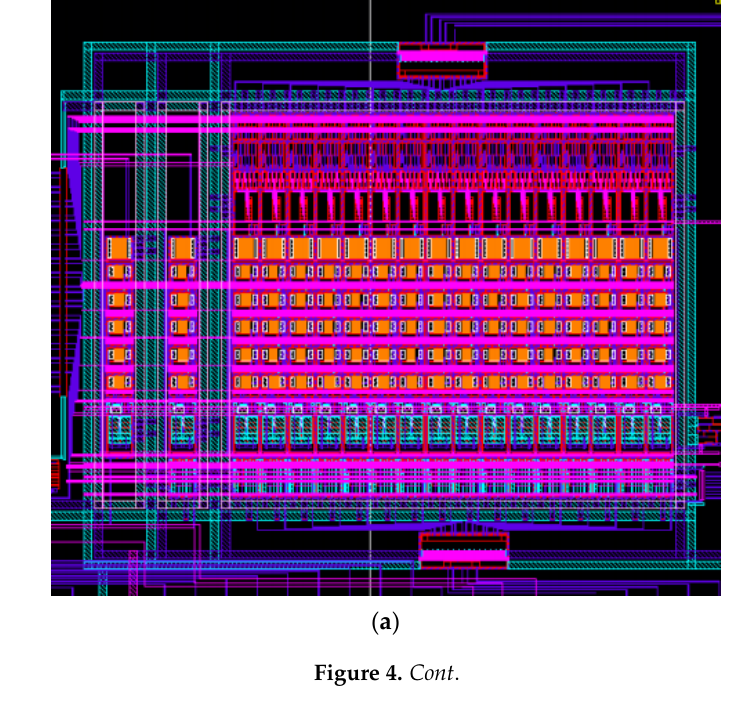
Figure 3. Resistance distribution of the active pixel.